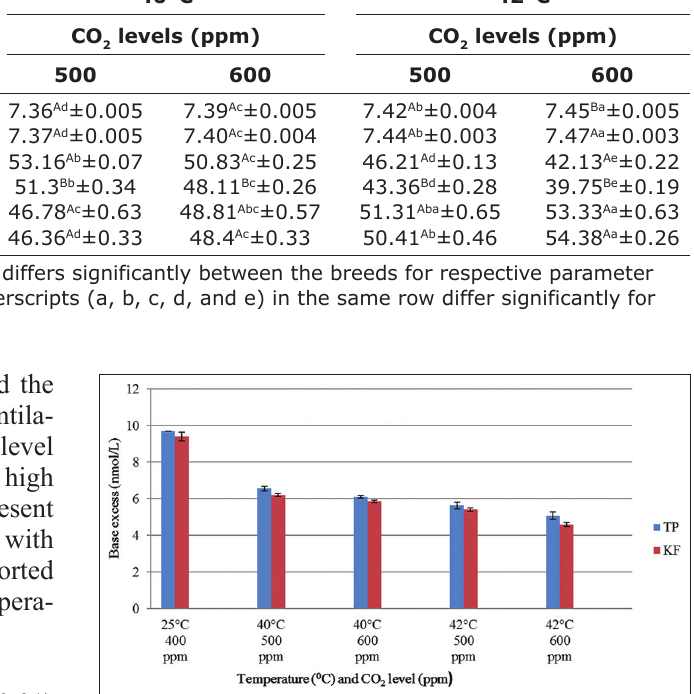
Table-3: Effect of elevated temperature and CO heifers. Parameters